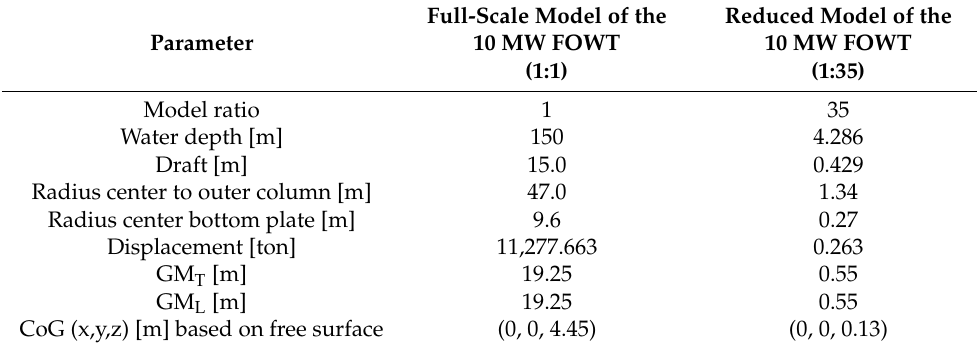
Table 7. Comparison of the full-scale model and reduced model of the 10 MW FOWT.